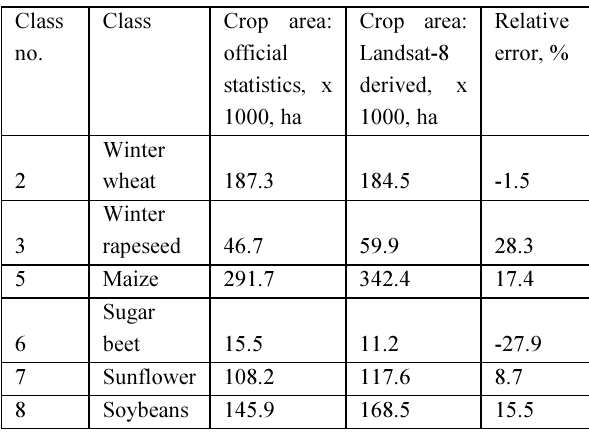
Table 3. Comparison of official statistics and crop